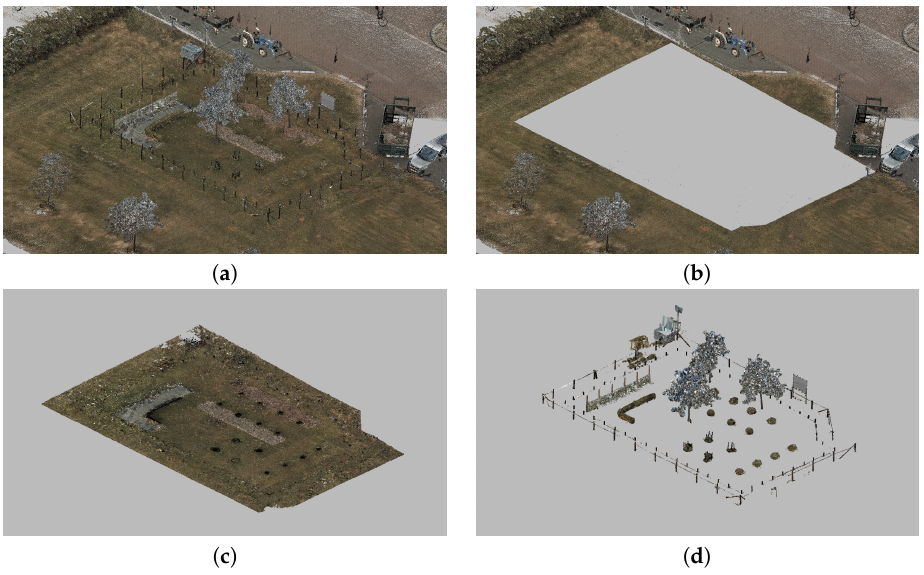
Figure 5. Segmentation of a point cloud. The input ( a ) is split into three parts: the background ( b ) is ignored points; ground ( c ) is the flat terrain; and objects ( d ) lie above the